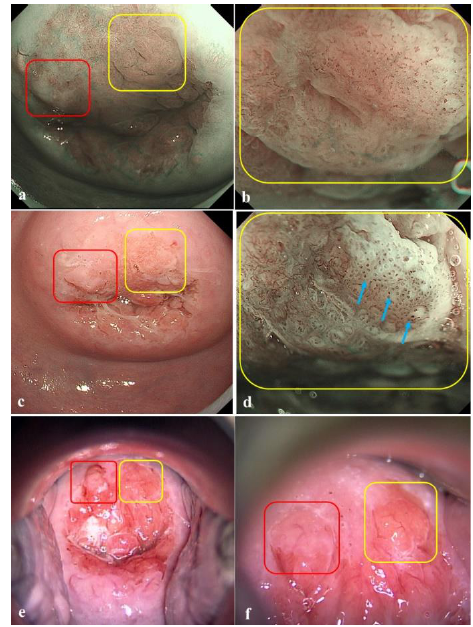
Figure 3. A representative case of cervical intraepithelial neoplasia grade 3 (CIN3) detected by ME-NBI but not with colposcopy. In narrow band imaging (NBI), an area with thin-white epithelium at the 1–2 o’clock position was observed in the cervix (yellow box) ( a ). ME-NBI revealed atypical vessels in the area with thin-white epithelium ( b ). Acetic acid endoscopy in white light imaging did not show acetowhite epithelium in the same area ( c ). ME-NBI with acetic acid contrasted the area with thin-white epithelium and atypical vessels, which appeared with dilatation and a meandering, irregular arrangement, and caliber change (blue arrows). This lesion was confirmed histologically as CIN3 ( d ). Colposcopy with acetic acid application showing a thin acetowhite lesion (Grade 1) at the 11 o’clock position. Biopsies confirmed a histological diagnosis of CIN1 (red box) ( e ). Magnified images ( f ) of those shown in ( e